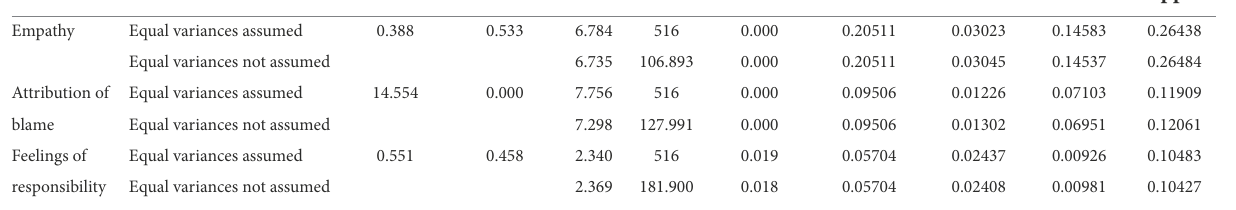
TABLE 8 T -test results for differences in empathy, attribution of blame, and feeling of responsibility by gender. Levene’s test for equality of variances